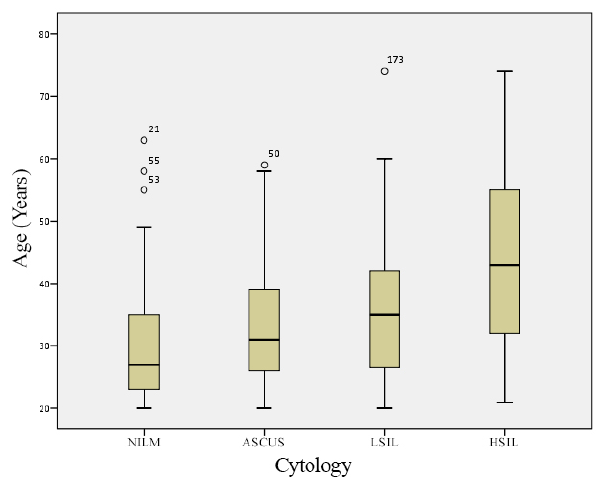
Figure 2. Age-specific analyses of the most prevalent HR HPV DNA in different cytological groups. NILM—negative for an intraepithelial lesion or malignancy; ASCUS—atypical squamous cells of unknown significance; LSIL—low-grade squamous intraepithelial lesions; HSIL—high-grade squamous intraepithelial lesions.